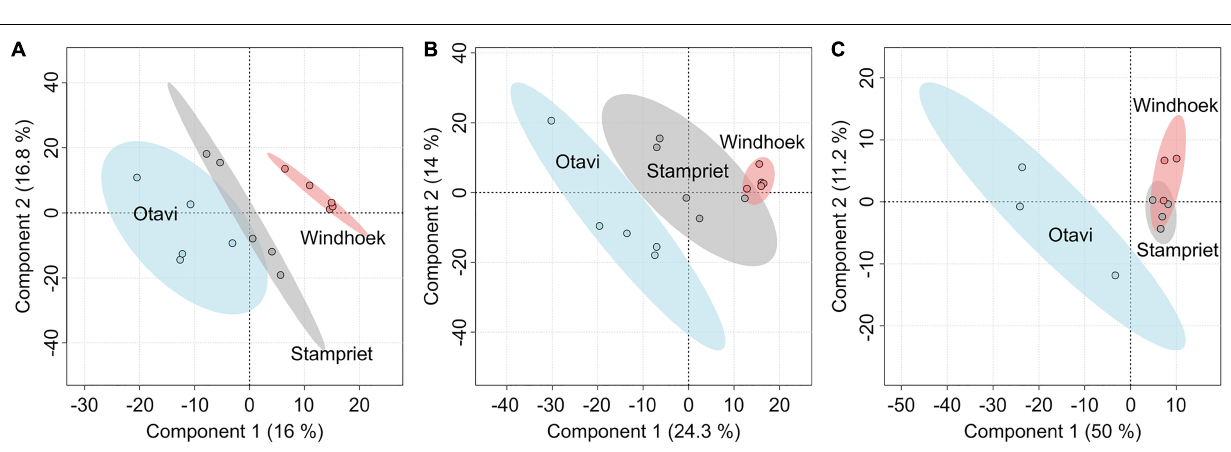
FIGURE 3 | Comparison of the volatilomes of the sampling sites Otavi, Windhoek, and Stampriet using partial least square discriminant analyses (PLS-DA). The diagrams are based on all identified and unknown VOCs of the nests (A) , webs (B) , and spiders (C) . The semi-transparent colored areas show the 95% confidence